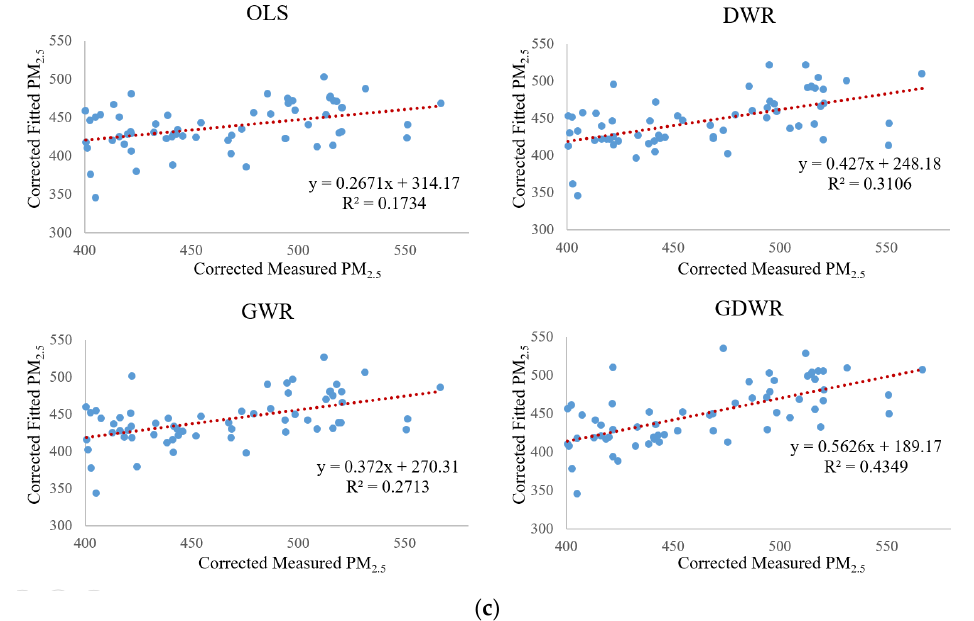
Figure 10. Scatter plot between corrected measured and corrected fitted PM 2.5 concentrations for model fitting grouping by corrected measured PM 2.5 : ( a ) 0~200 μ m, ( b ) 200~400 μ m, ( c ) 400~600 μ m.